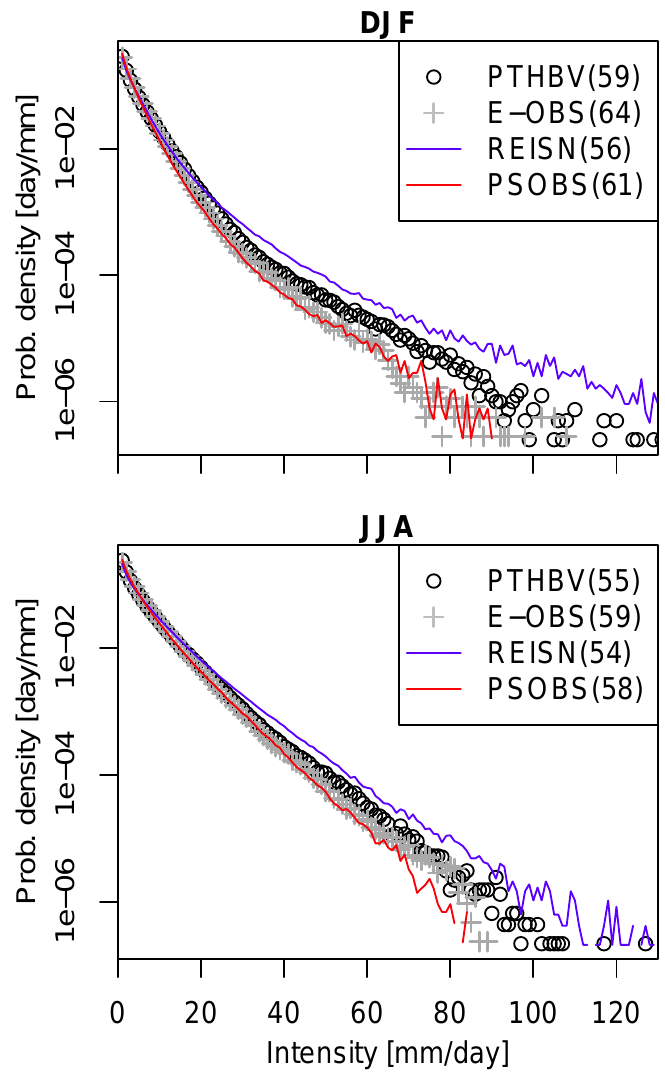
Figure 3. PDF of wet day precipitation intensities for PTHBV, E-OBS, REISN and PSOBS (symbols according to legend), for DJF ( top ) and JJA ( bottom ). The dry day probability (%) is given in the